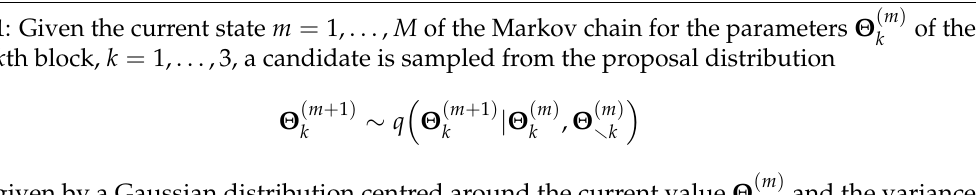
Algorithm 1 RW–MH algorithm for posterior